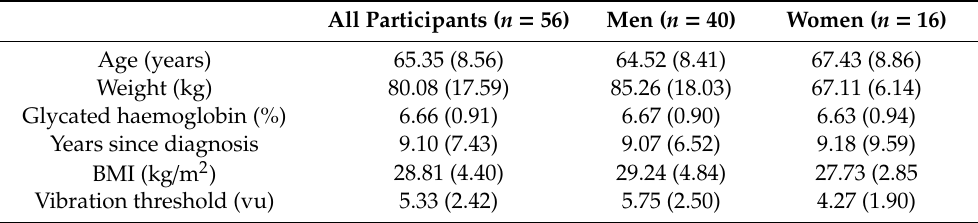
Table 1. Participant characteristics.